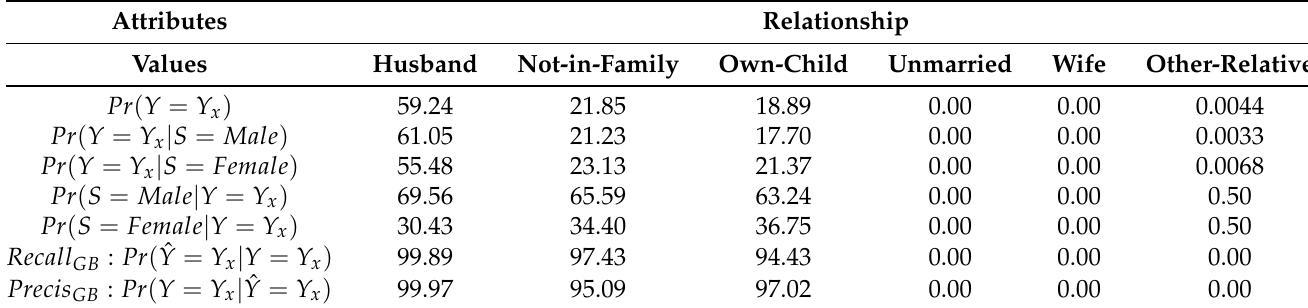
Table 7. Sanitized distributions of the attribute relationship . Gradient Boosting (GB) Recall ( Recall GB ) and Precision ( Precis GB ) when predicting the relationship values. Note that the classifier is trained without the sensitive attribute. Numerical values are given in